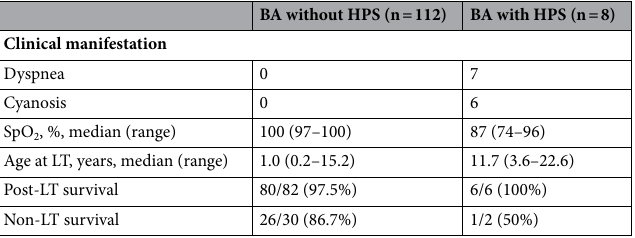
Table 2. Comparison of clinical manifestation and outcomes between BA with HPS and BA without HPS. LT Liver transplantation.